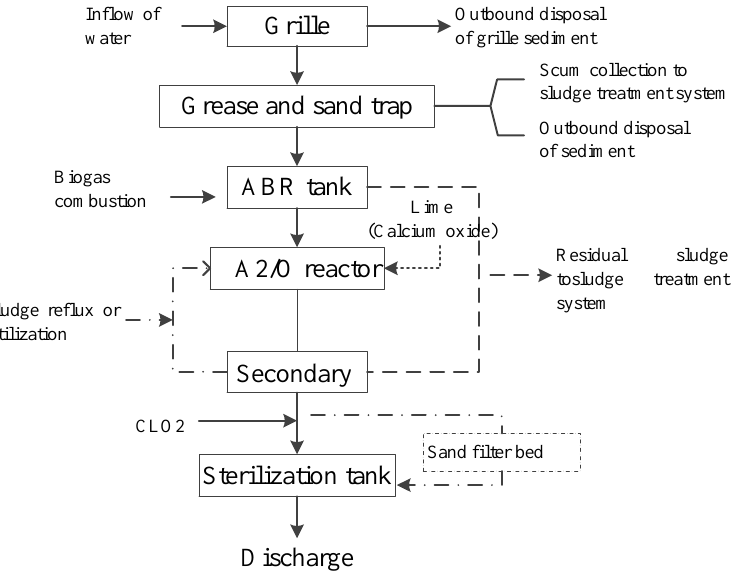
Figure 2. ABR + A2/O process flow diagram.